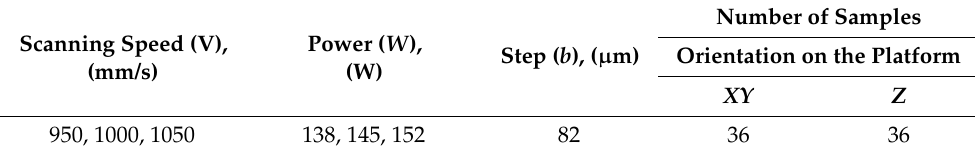
Table 5. Ranges for 3D-printing regimes of samples made from